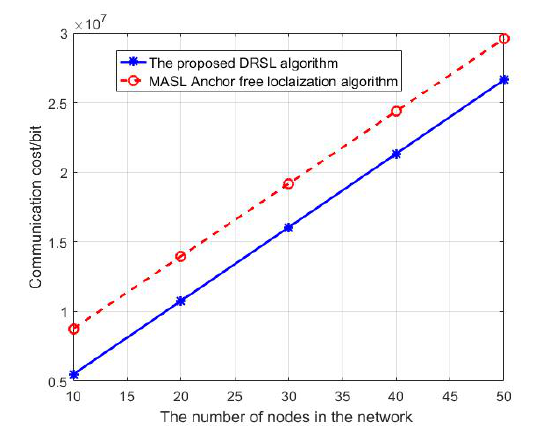
Figure 15. The communication cost